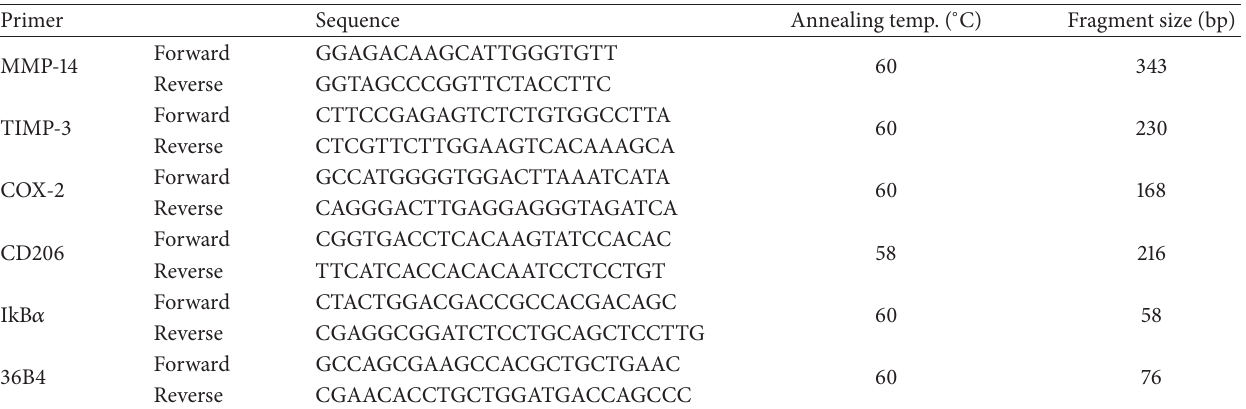
Table 2: Primers for quantitative